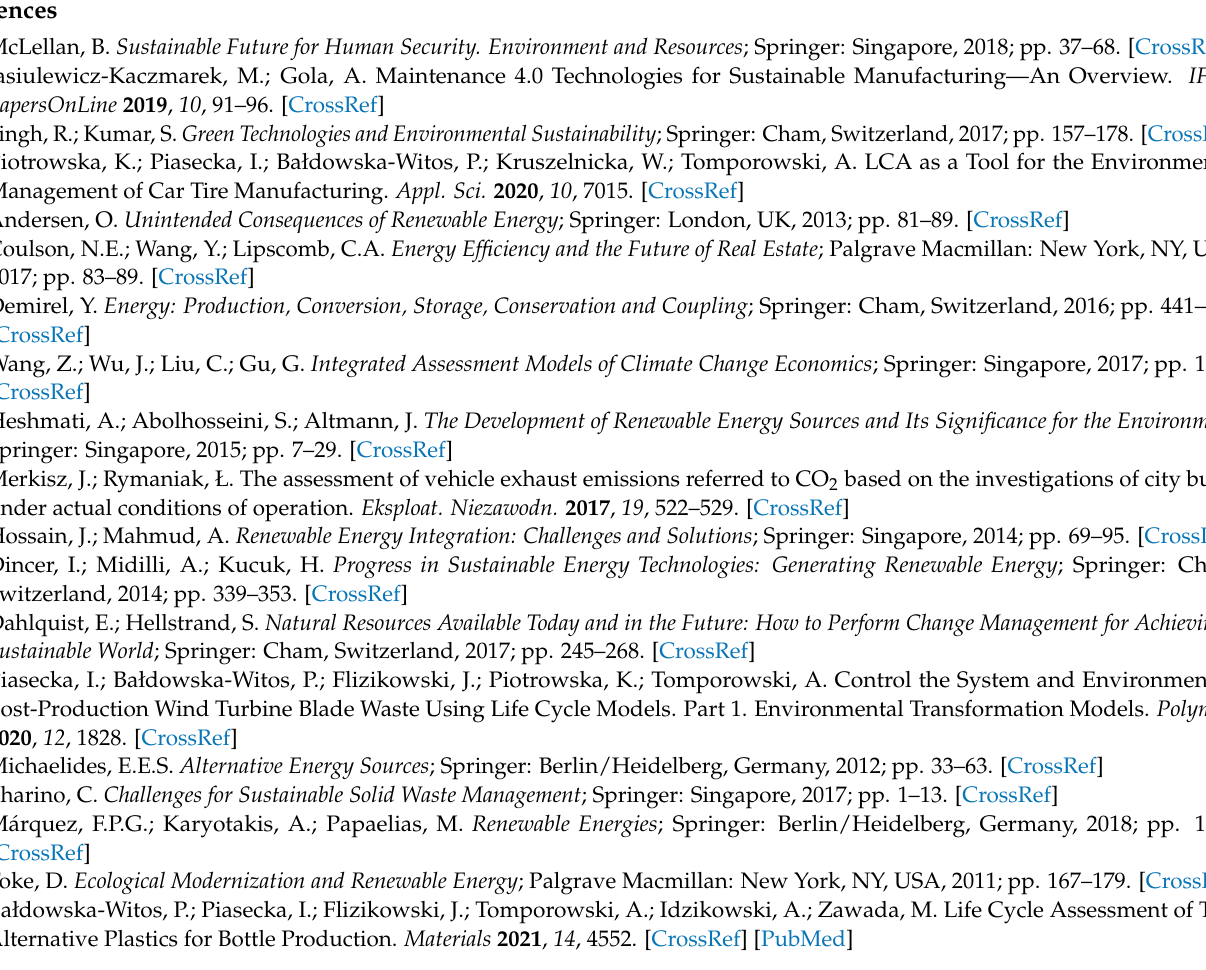
(unit: Pt), Table S15: Grouping and weighting results of environmental consequences for the impact category Water consumption, Human health (unit: Pt), Table S16: Grouping and weighting results of environmental consequences for the impact category Water consumption, Terrestrial ecosystem (unit: Pt), Table S17: Grouping and weighting results of environmental consequences for the impact category Water consumption, Aquatic ecosystem (unit: Pt), Table S18: Grouping and weighting results of environmental consequences for the damage category Ecosystems (unit: Pt), Table S19: Grouping and weighting results of environmental consequences for the damage category Resources (unit: